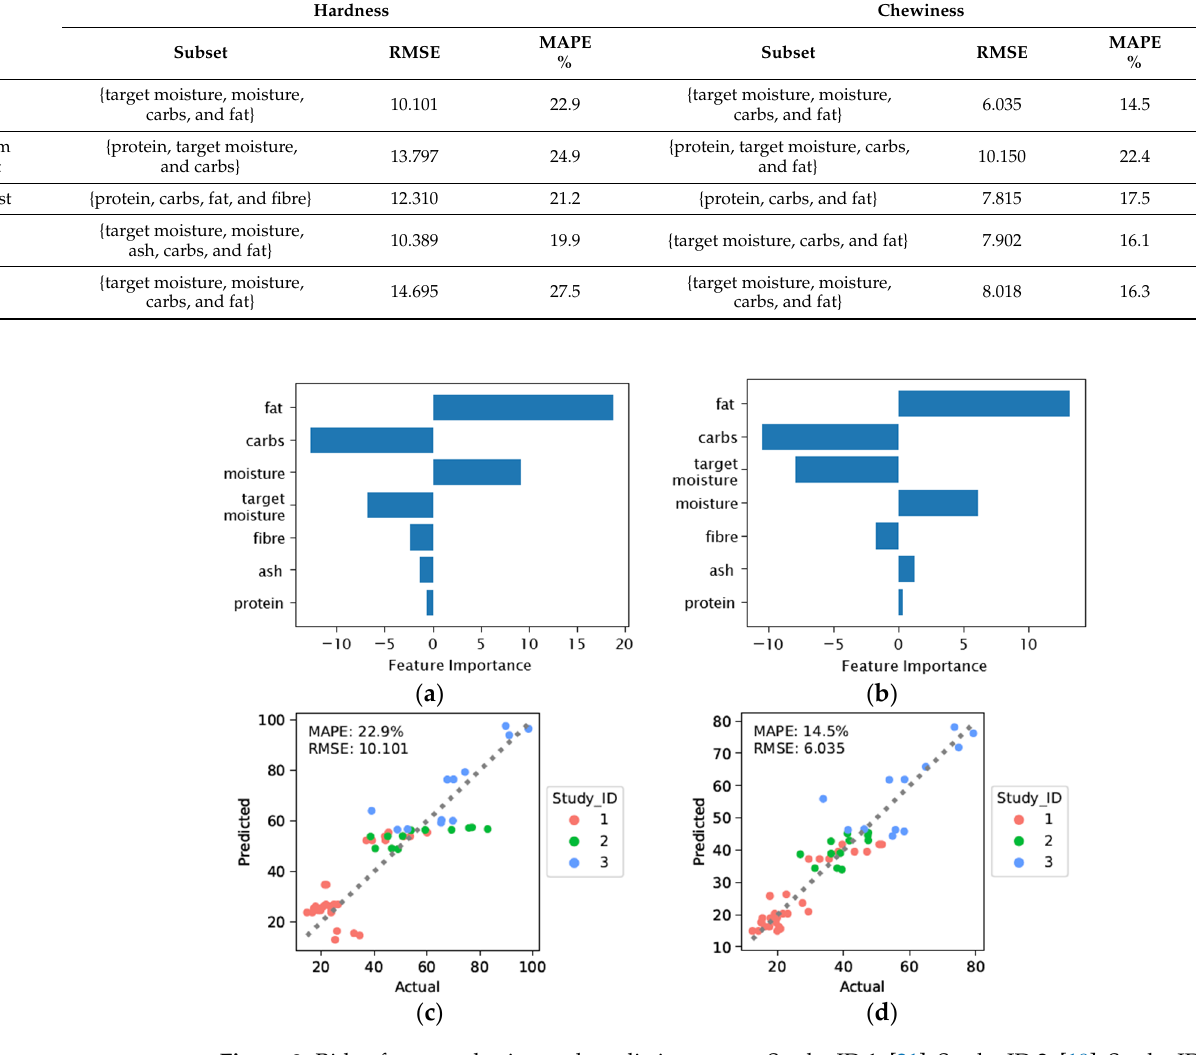
Figure 3. Ridge feature selection and prediction scores. Study_ID 1: [21], Study_ID 2: [19], Study_ID 3: [20]. ( a ) Build-in feature importance scores for prediction of Hardness; ( b ) Build-in feature importance scores for prediction of Chewiness; ( c ) Plot of predicted and actual Hardness values; ( d ) Plot of predicted and actual Chewiness values. Table 2. Prediction Performances for the Textural Properties.